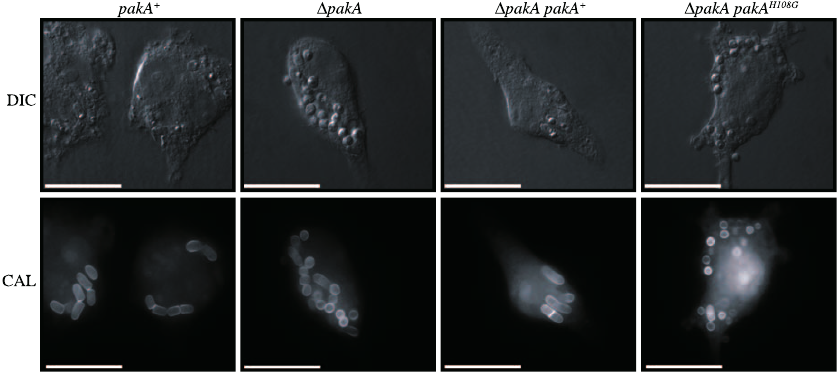
Figure 5. PakA Is Required for Conidial Germination In Vivo LPS activated J774 murine macrophages infected with conidial suspensions of the wild-type ( pakA þ ), D pakA , D pakA pakA H108G , and D pakA pakA þ strains. After 24 h, numerous yeast cells dividing by fission were observed in macrophages infected with wild-type ( pakA þ ) or D pakA pakA þ conidia. In contrast, conidia of both the D pakA and D pakA pakA H108G strains remain predominately ungerminated in infected macrophages. Images were captured using DIC or with epifluorescence to observe calcofluor stained fungal cell walls (CAL). Scale bars, 20 l m.